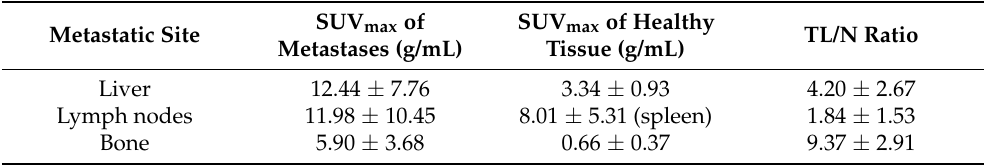
Table 3. Tumoral uptake versus healthy tissue uptake of 99mTc-EDDA/HYNIC-TOC in the most frequent sites of the